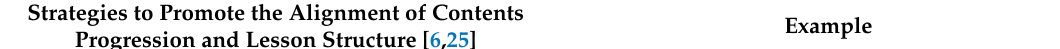
Table 2. Strategies to Design the Lessons Built on Teaching Games for Understanding Pedagogical Features and Examples (See More Details about Each Strategy in Table